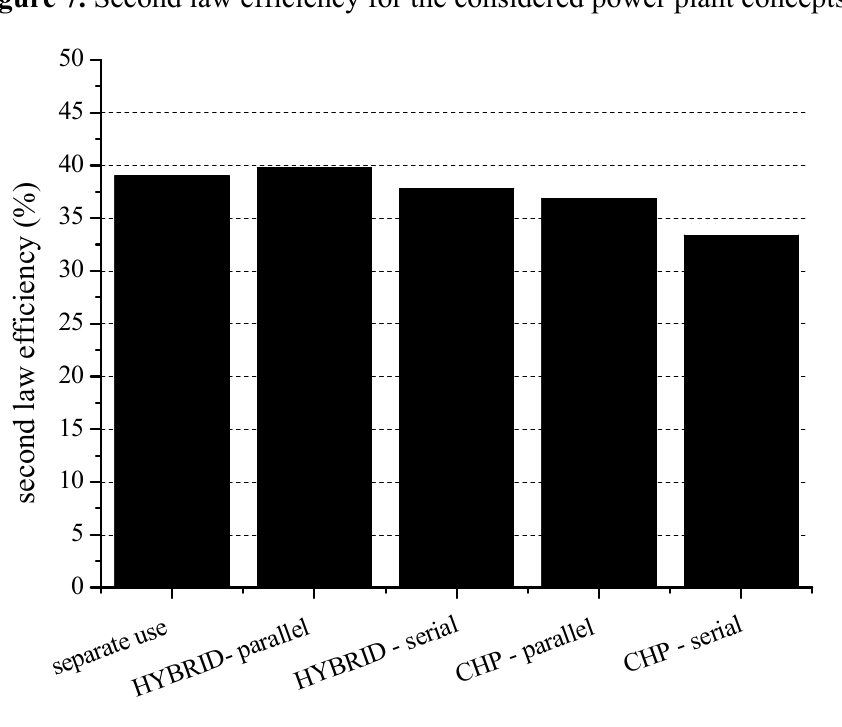
Figure 7. Second law efficiency for the considered power plant